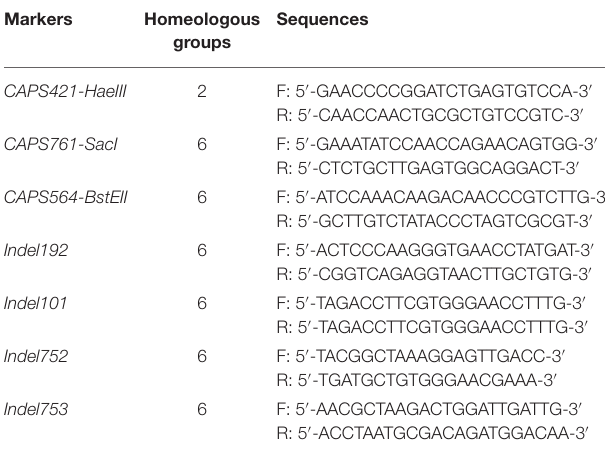
TABLE 1 | Markers developed specific to Thinopyrum ponticum .